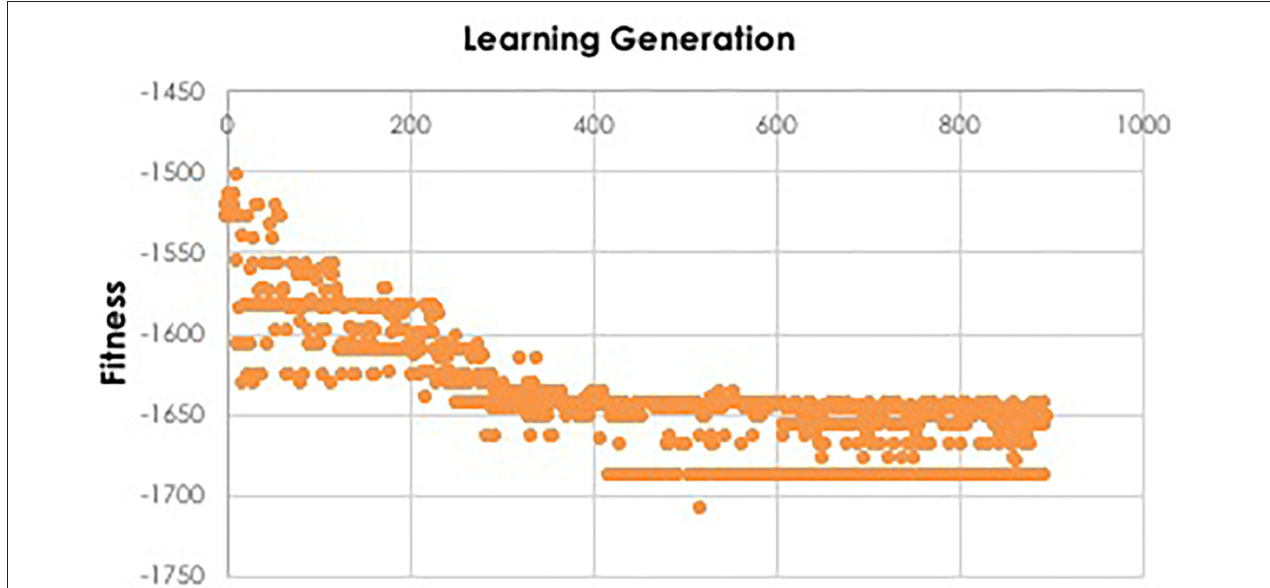
FIGURE 4 | Fitness function during IEL learning. During model training, the fitness function is used by IEL to select best-performing models for recombination and mutation. Initial learning may be terminated when the BIC plateaus, as shown here for training the XGBoost model to predict autism which plateaus after ∼ 130 learning generations or ∼ 400 models, since 3 best-performing models are retained per generation.